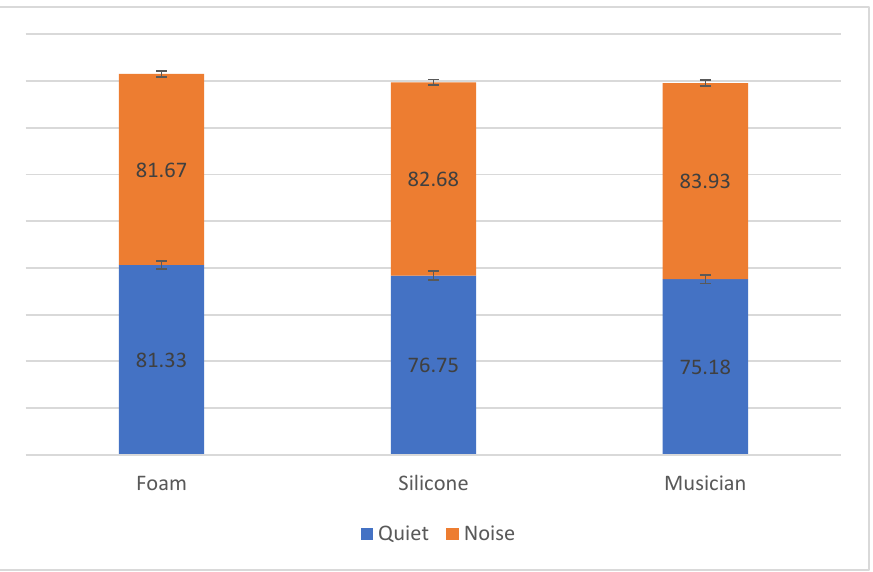
Figure 5. Percentage of correct words from sentences in quiet and noise with and without HPD.